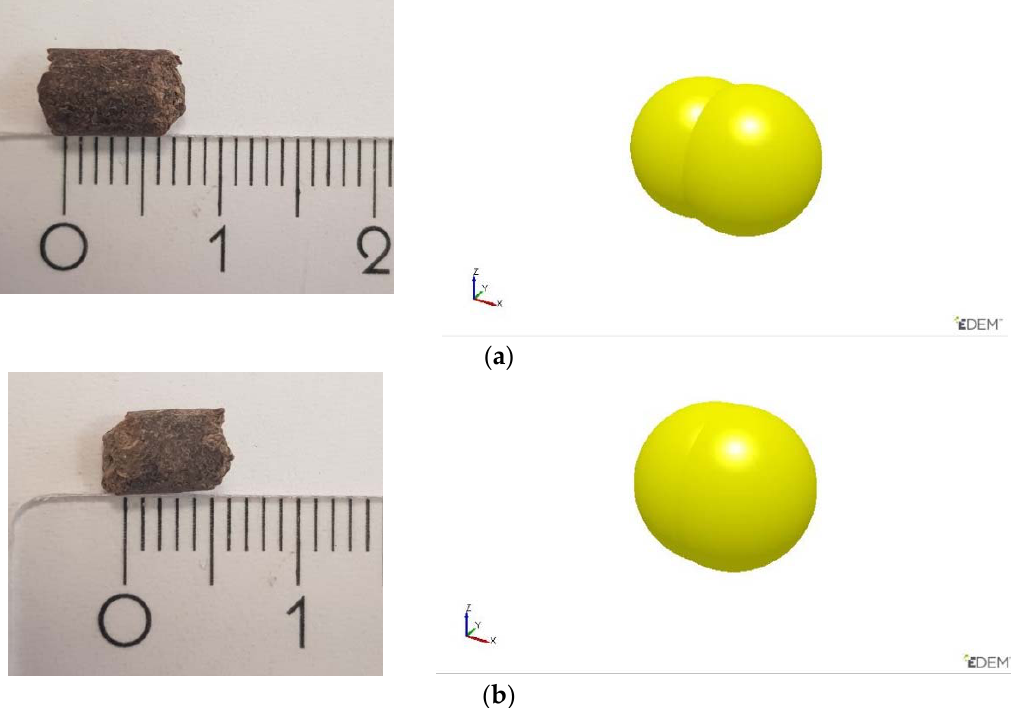
Figure 2. The natural granule photo ( left side ) and the model of the particle ( right side ) are shown: ( a ) Fertilizer I; ( b ) Fertilizer II.